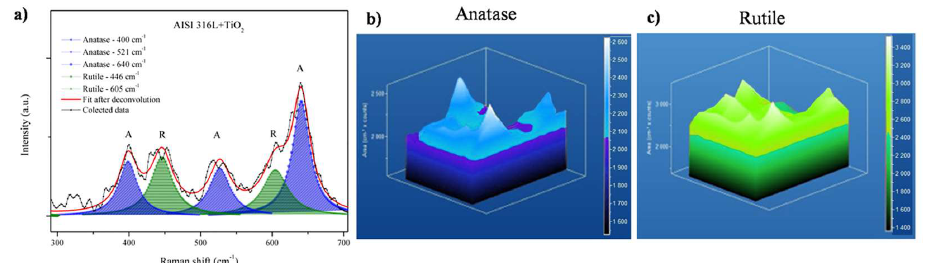
Figure 6. Raman mapping of the AISI 316L + TiO 2 film. ( a ) Overlap of 20 Raman shift plots, with the positions of the anatase and rutile bands indicated, respectively. Three-dimensional Raman mapping of ( b ) the anatase band (from 135 to 175 cm −1 ) and ( c ) the rutile band (from 595 to 635 cm −1 ).